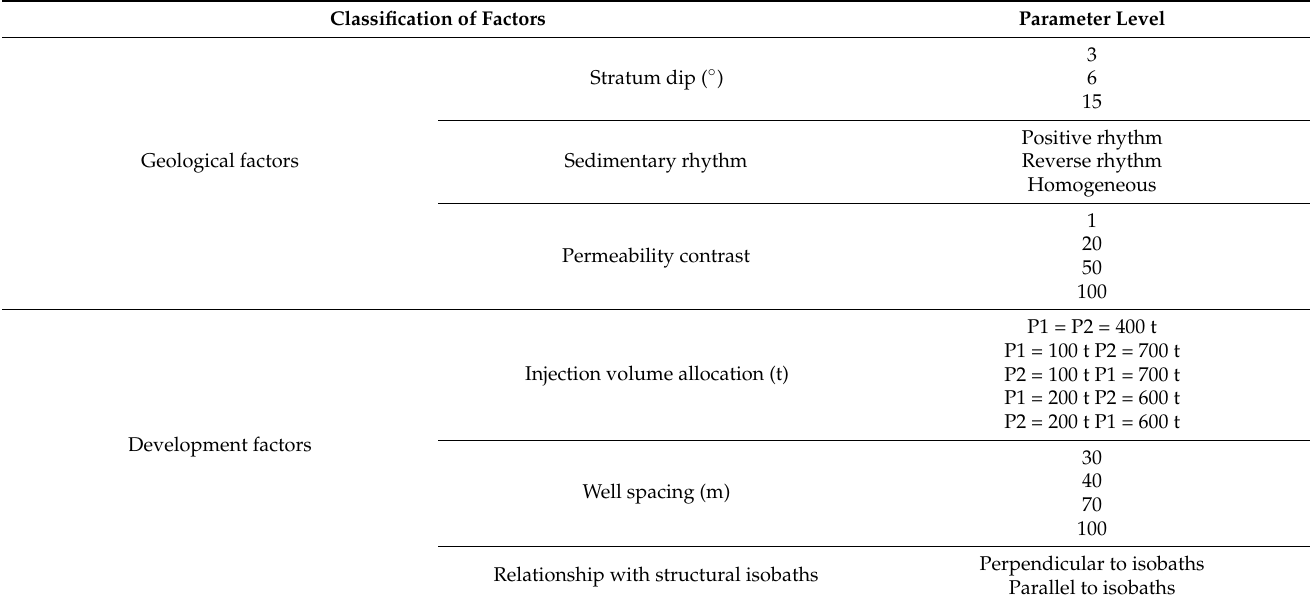
Table 5. Factors and parameter levels of the two-well synergistic